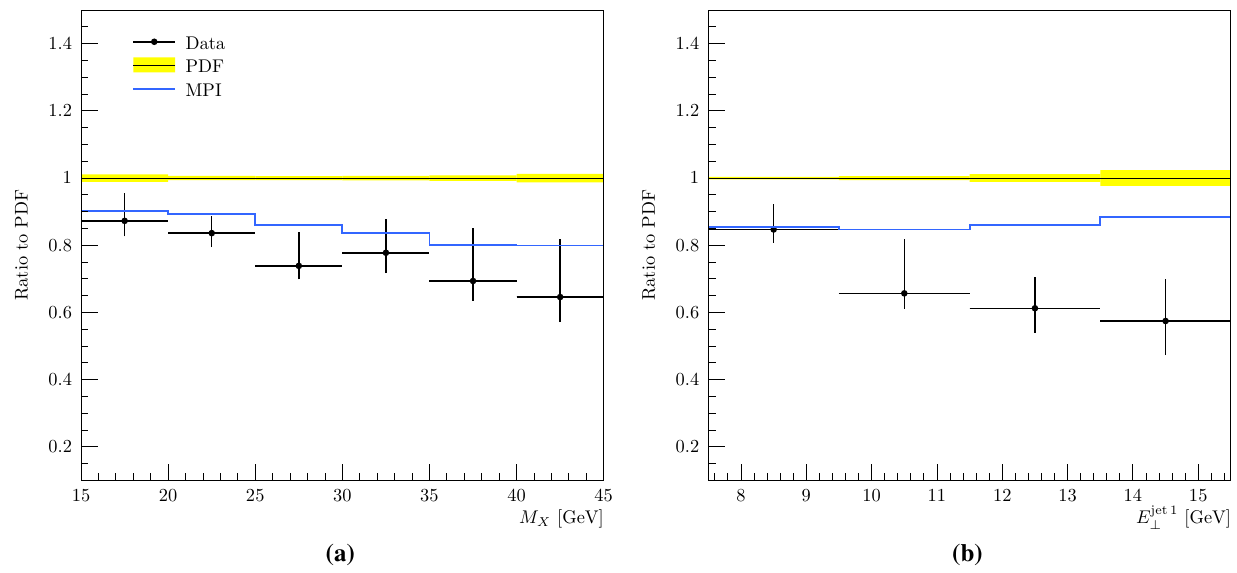
Fig. 14 The predicted gap suppression factors as a function of M X ( a ) and E jet1 ⊥ ( b ) compared to the ZEUS analysis